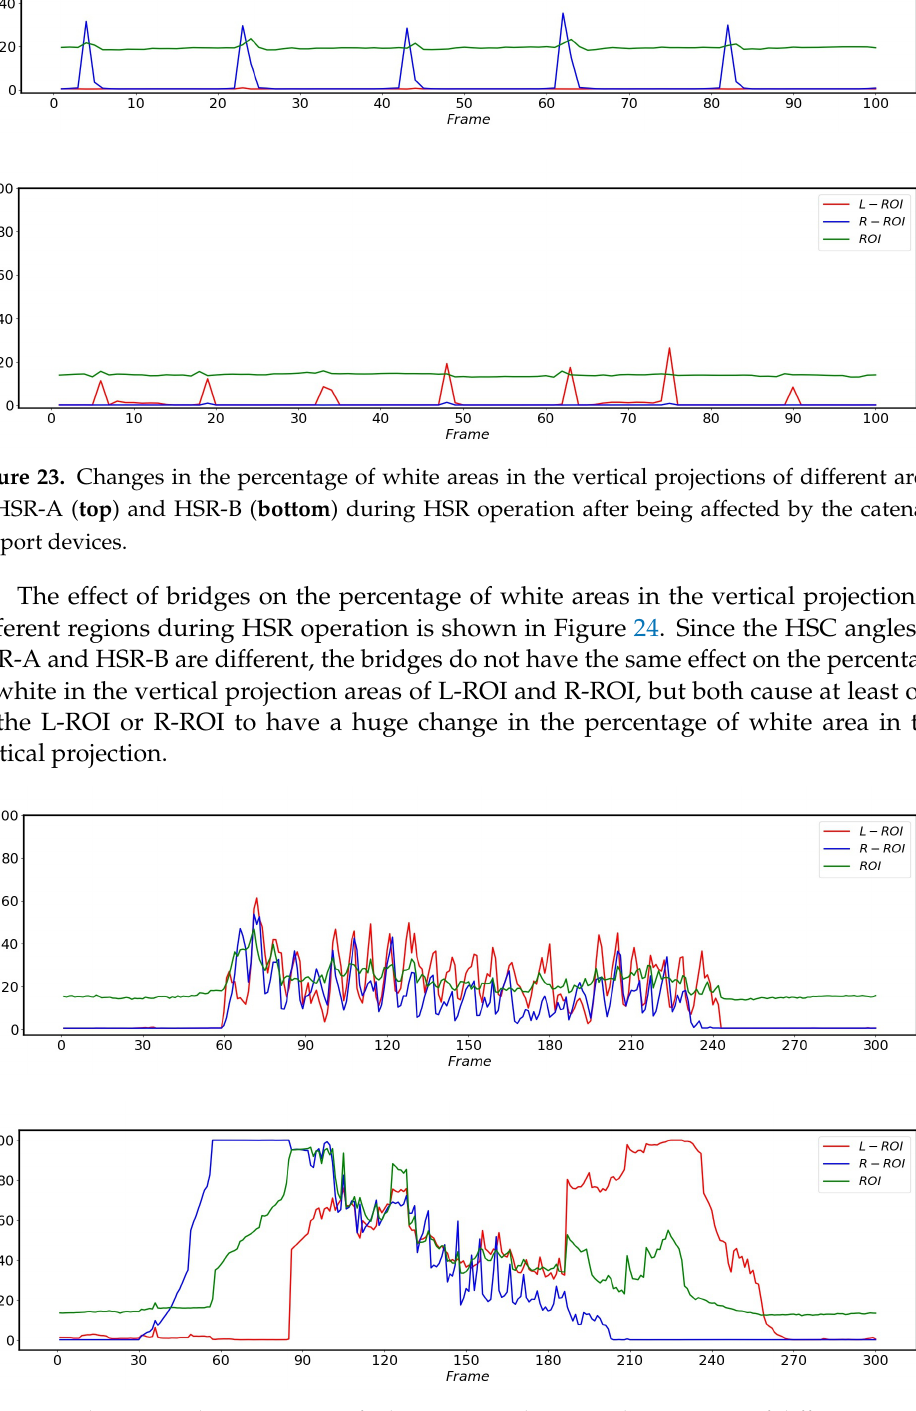
Figure 24. Changes in the percentage of white areas in the vertical projections of different areas of HSR-A ( top ) and HSR-B ( bottom ) during HSR operation after being influenced by the